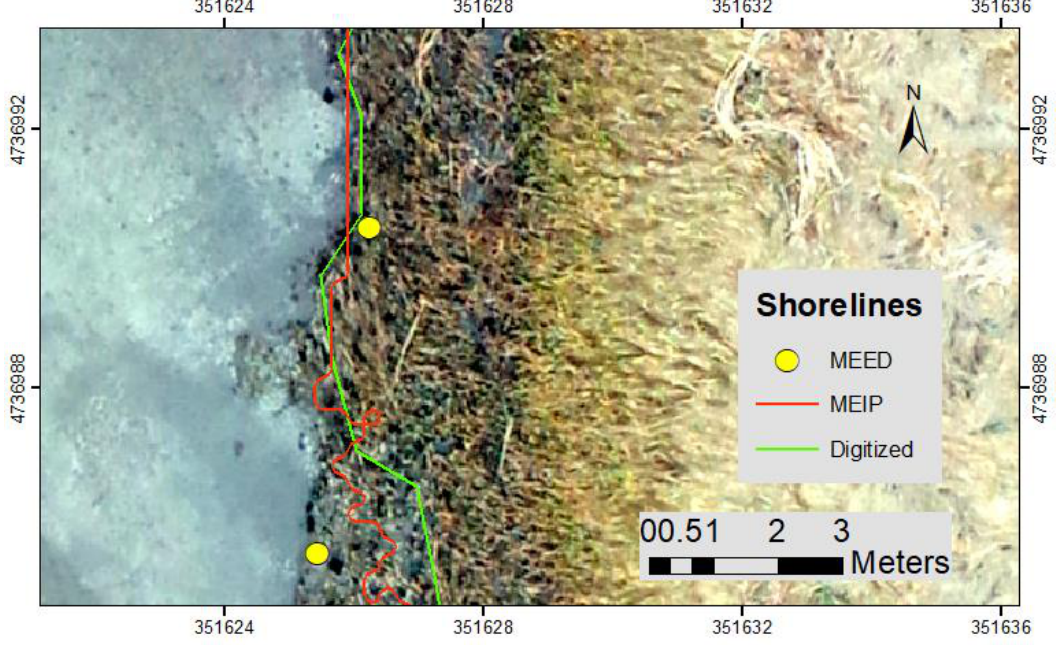
Figure 9. Plum Island Estuary, MA, UAS imagery. Yellow dots: Marsh scarp from MEED, red line: Unvegetated / vegetated line from MEIP, green line: Digitized edge of vegetation. The challenge in determining the location of shoreline with the heads-up digitization can be seen in the lower half of the image where the operator selected a somewhat subjective marsh shoreline, MEED method identified the maximum slope, and MEIP method identified a location somewhere between the two. 306 The NAIP data and CoNED datasets were also used as inputs to the MEIP method to calculate 307 the unvegetated/vegetated line. The resulting line was compared to both the scarp calculated from 308 the MEED method using UAS data and the unvegetated/vegetated line calculated from the MEIP 309 method using UAS data. The line found using NAIP data did not follow the others as closely (Figures 310 6b and 7b). This is partially because the resolution of the NAIP and CoNED data is 1 meter, in contrast 311 to the UAS resolution of 5 centimeters. Another factor might be that the NAIP imagery was flown on 312